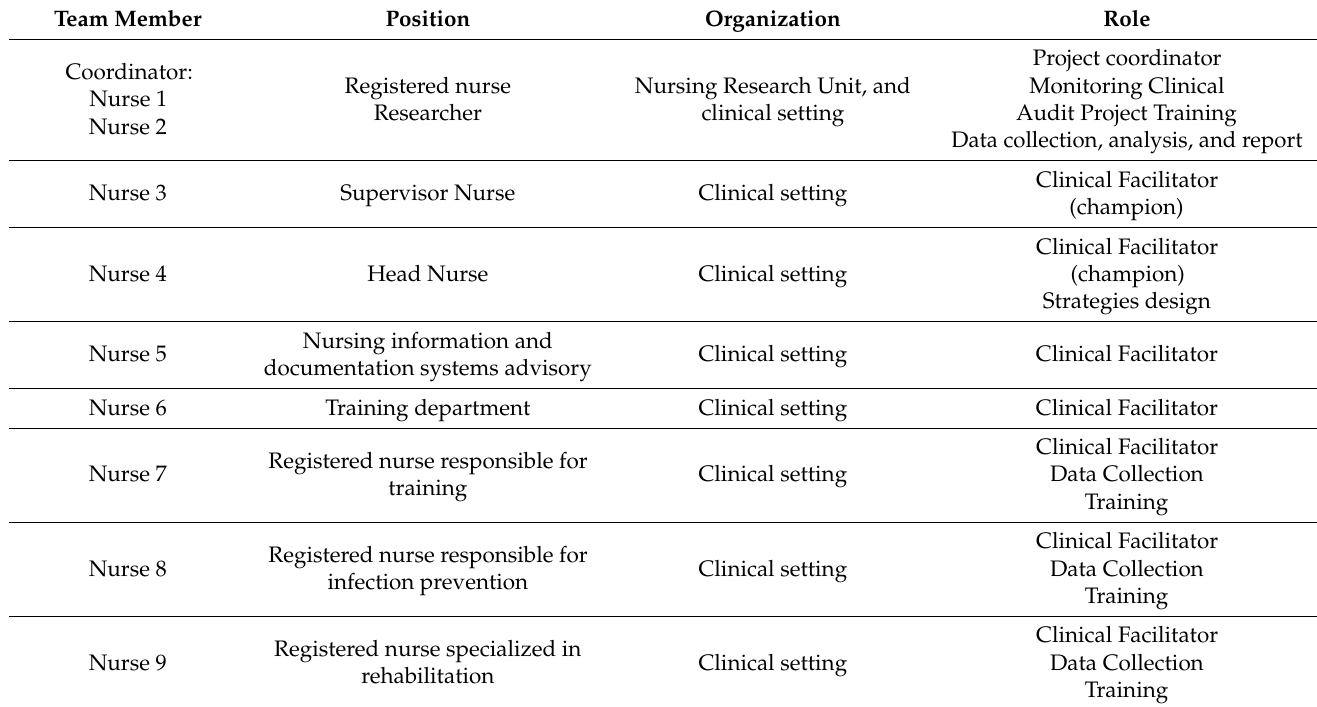
Table 1. Team members, their positions, organizations, and